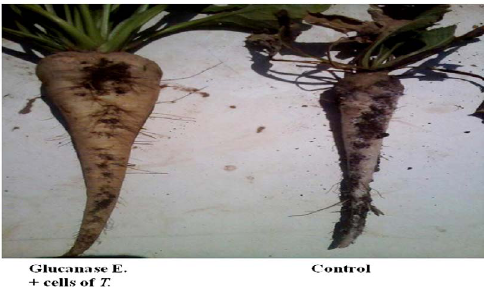
Fig. 3. Effect of application of β-glucanase enzyme and Trichoderma harzianum kj831197 cells on weight of sugar beet roots infected with S. rolfsii.